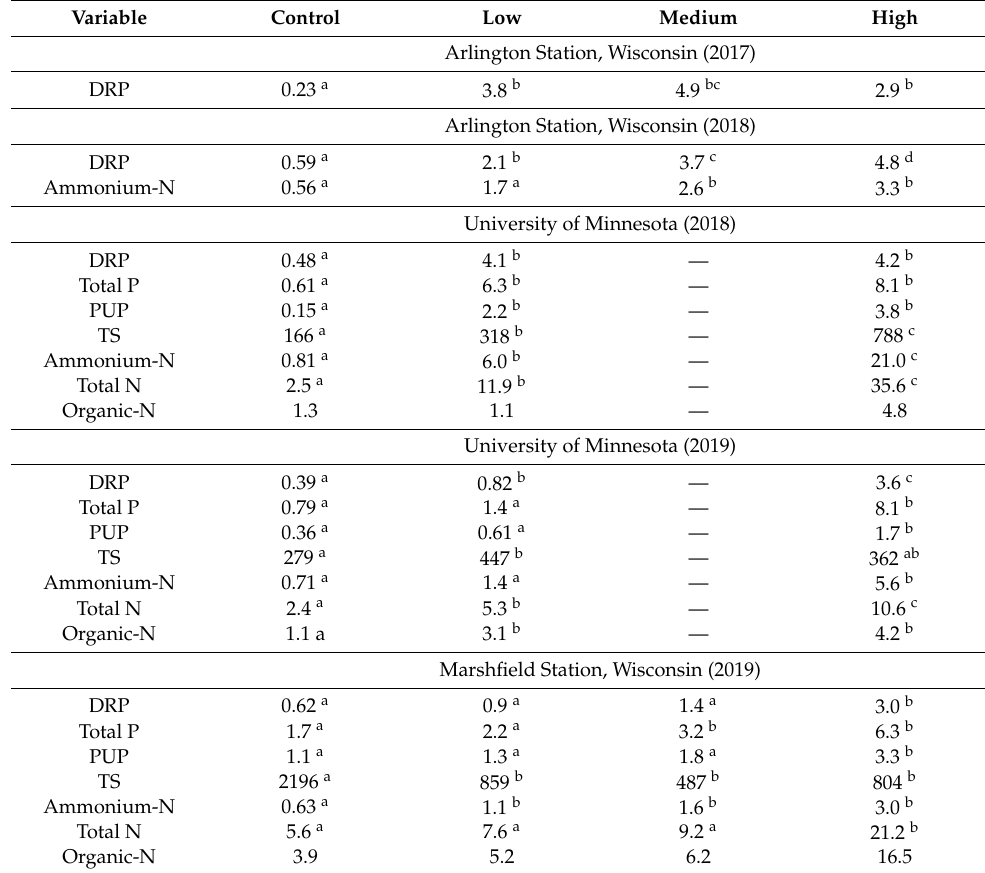
Table 2. Average concentrations by treatment for each site and